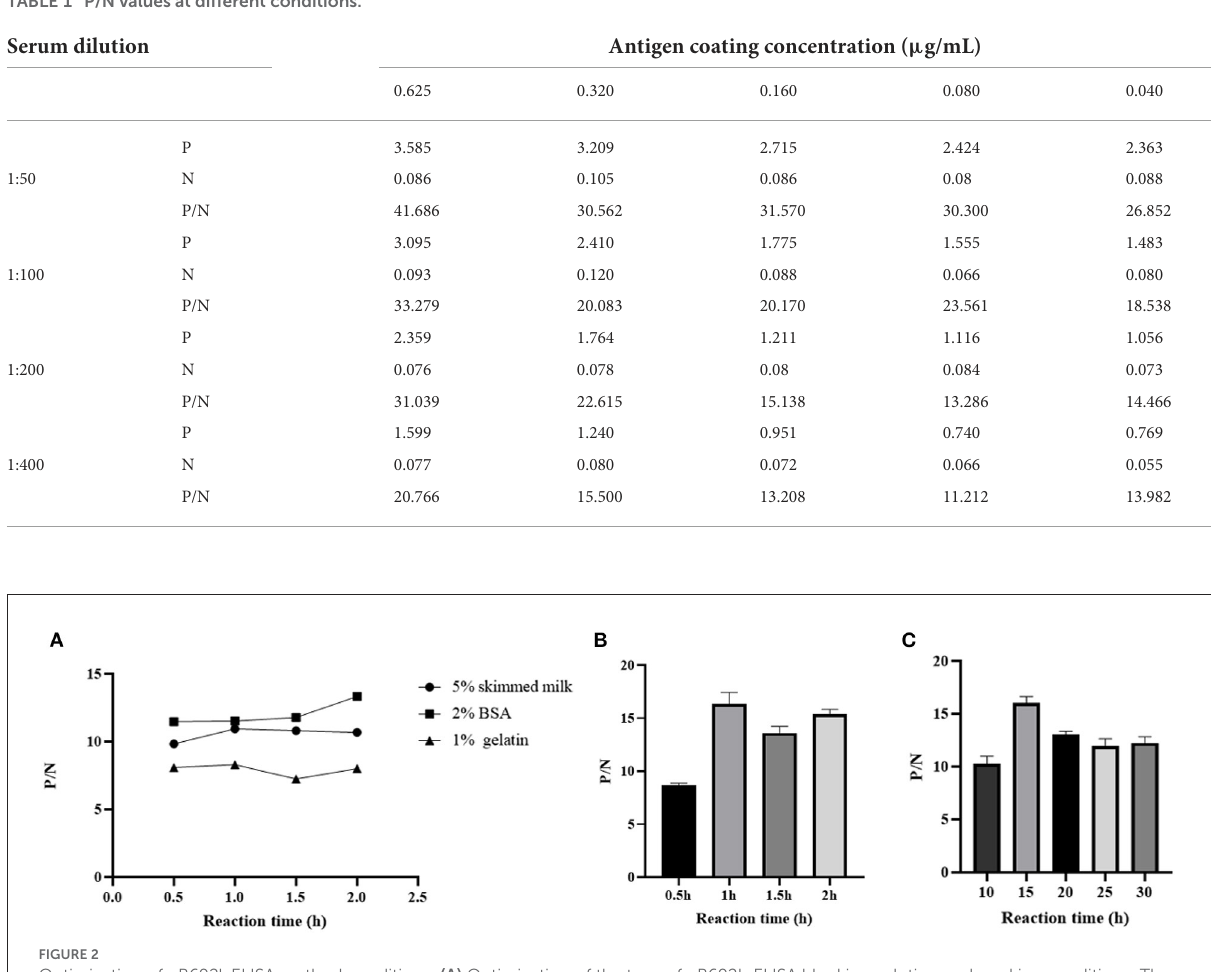
TABLE 1 P/N values at different conditions.